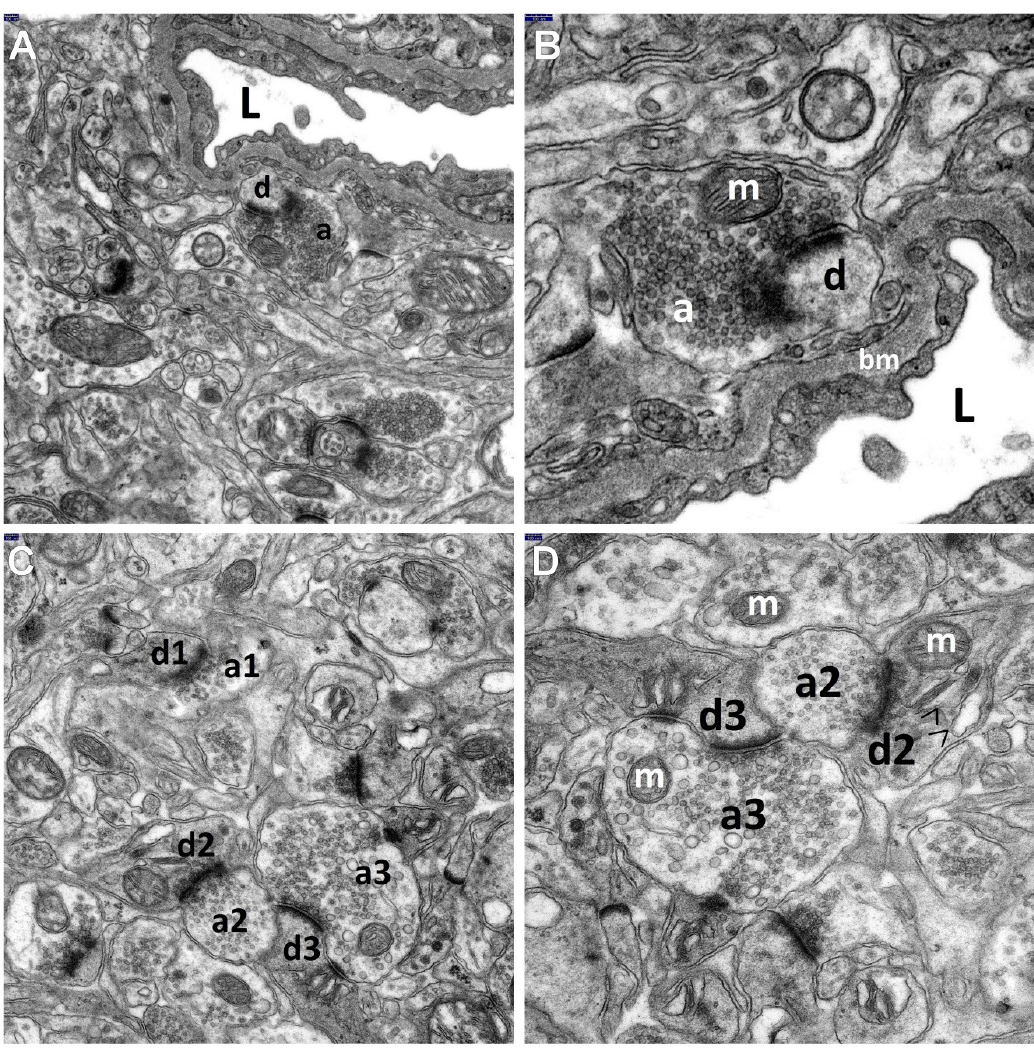
Figure 4. The ultrastructural pictures show the neuroprotective influence of topiramate on the synaptic endings of the neocortex of the temporal lobe in the TPM + HS group. Note that the cytoplasm of these structures is much less swollen as compared to the FS group. ( A , B ) Visible is a particularly beneficial effect of the drug on the synaptic endings located directly in the perivascular zone. In a very close vicinity to a quite well-preserved capillary lined with normal endothelial lining, neuropil components can be seen, especially synapses, relatively unchanged or showing slight signs of swelling as compared to the HS group. A greater magnification ( B ) well demonstrates morphological details of the presynaptic (a) and postsynaptic parts of the synapse, (d) directly adhering to the basement membrane (bm) of the capillary. The axonal end-bulb of the presynaptic part contains a large quantity of synaptic vesicles quite evenly distributed within the axoplasm and normal mitochondrion (m); the postsynaptic part (d) is relatively well preserved. Visible are the long active synaptic zone of this axodendritic junction and the well-preserved postsynaptic density thickness. L—perfused capillary lumen. ( C , D ) The electonograms clearly demonstrate a favorable effect of TPM on the neuropil components, among which numerous quite well-preserved synaptic junctions are the most visible. Normal picture of the mitochondria (m) present within the cytoplasm of axonal (a) and dendritic (d) end-bulbs. Although some of the axonal-end-bulbs (a2 and a3) are still enlarged, they are filled up with relatively abundant synaptic vesicles evenly distributed within the axoplasm. The dendroplasm of some of the postsynaptic parts of the synapses shows a preserved dilation of the granular endoplasmic reticulum channels (>) (well visible in Figure 4D). Axodendritic junctions show an increase in the length of the synaptic active zone and a relatively well-preserved postsynaptic density. Scale bar: 100 nm ( A – D